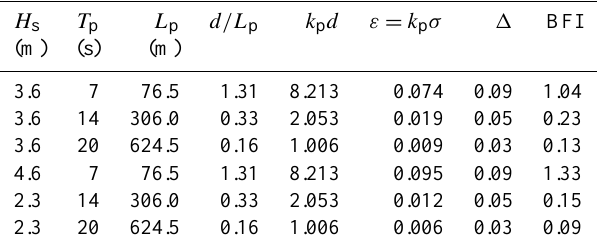
Table 2. Characteristics of the individual spectral components.